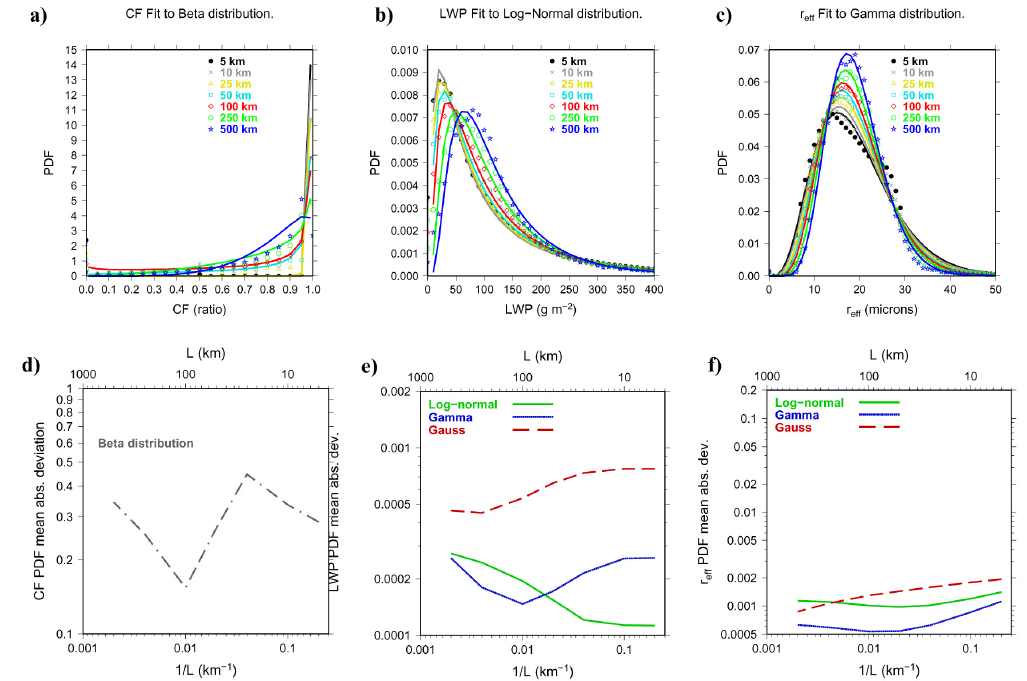
Fig. 2. (a–c) Symbols show the observed values at different spatial averaging scales. Solid lines are the designated least-squares fits. All PDFs for all variables are non-symmetric. LWP and r eff have respectively log-normal and exponential tails that capture the infrequent high values. (d–f) Mean absolute deviations between the observed global CF (d) , LWP (e) , r eff (f) and the analytical PDFs after a nonlinear least-squares